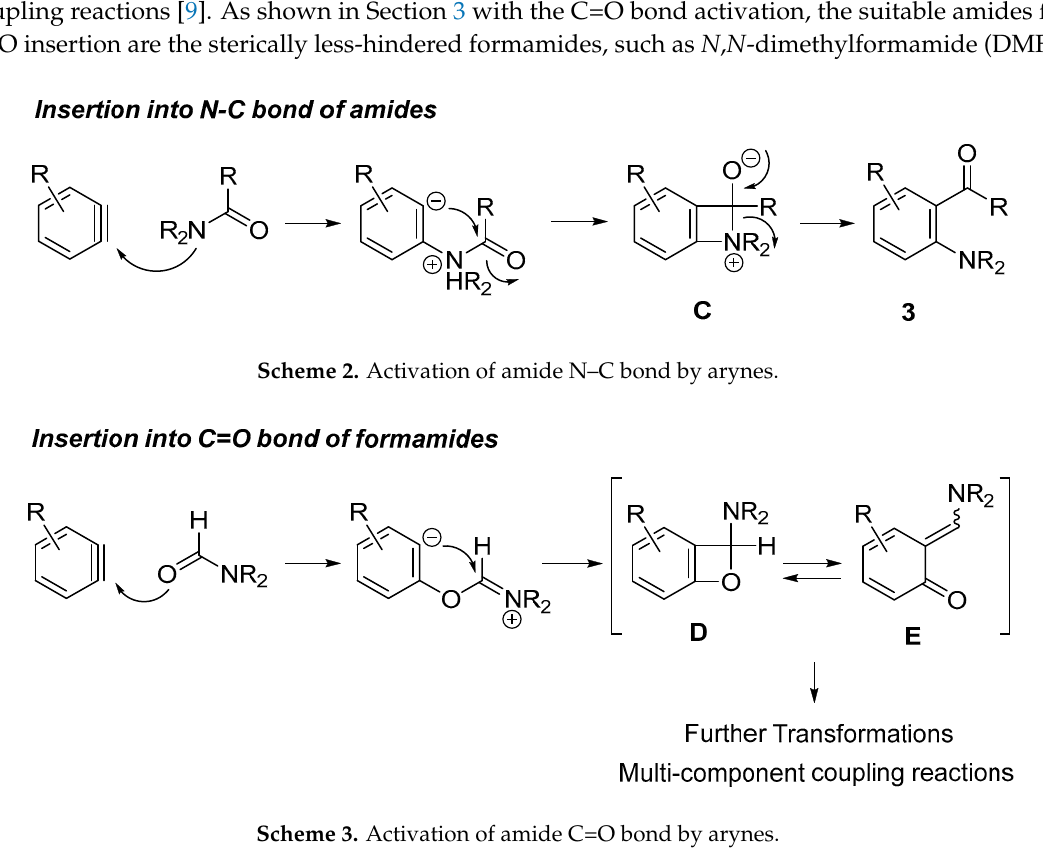
Scheme 3. Activation of amide C=O bond by arynes.